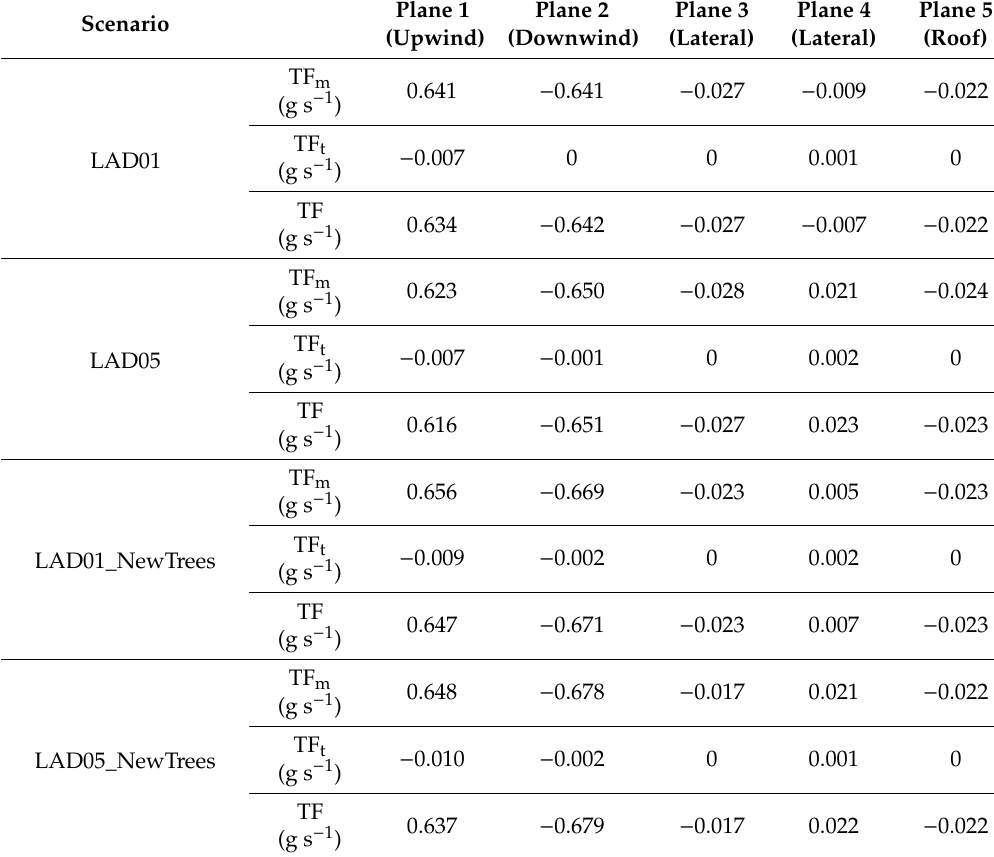
Table 4. Total pollutant fluxes at each plane due to mean flow ( TF m ), turbulent fluctuations ( TF t ) and both contributions ( TF ).